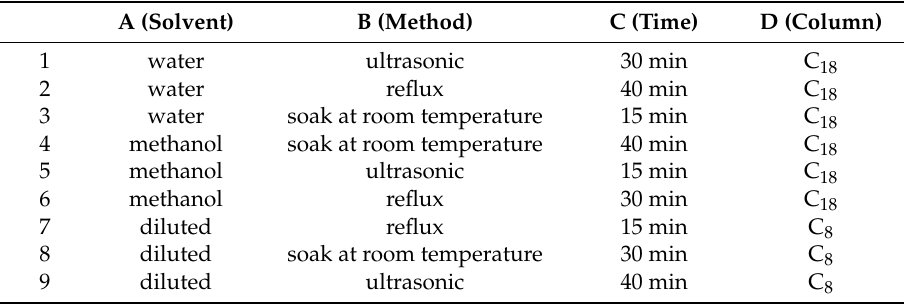
Table 2. Orthogonal experiment table of G. elata ’s extraction